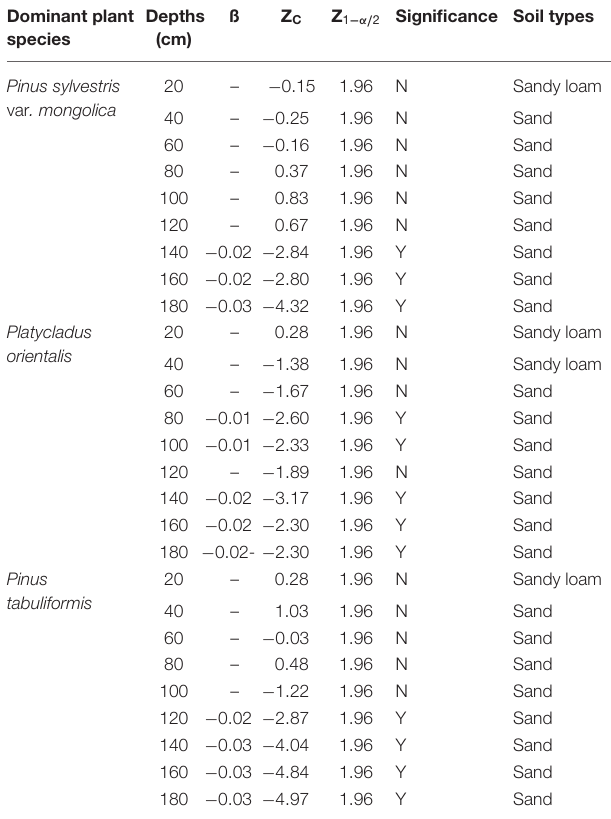
TABLE 3 | Mann–Kendall test and field trends of soil water content in